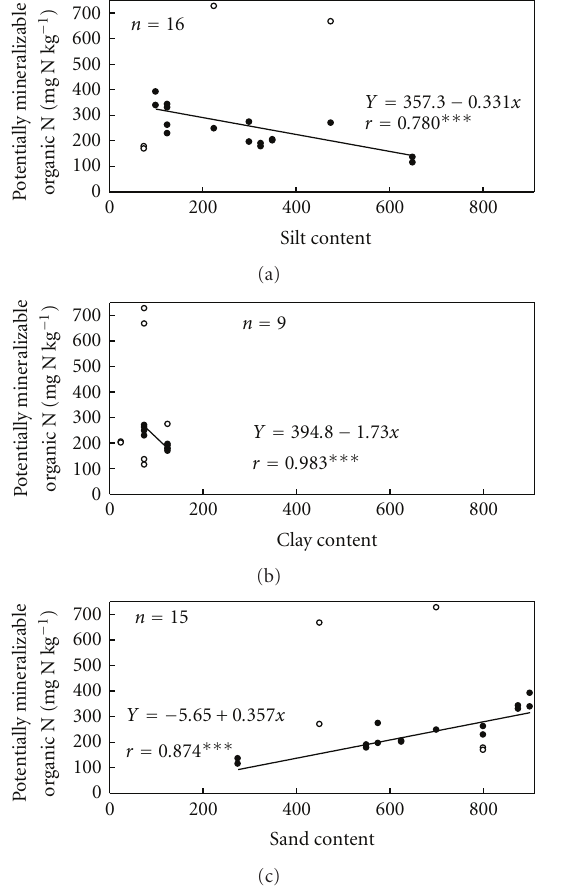
Figure 8: Relationships between potentially mineralizable organic nitrogen (N 0 ) and soil organic nitrogen (a) and soil organic carbon (b) in soils amended with broiler litter 1 or 2. The open circles did not fit the